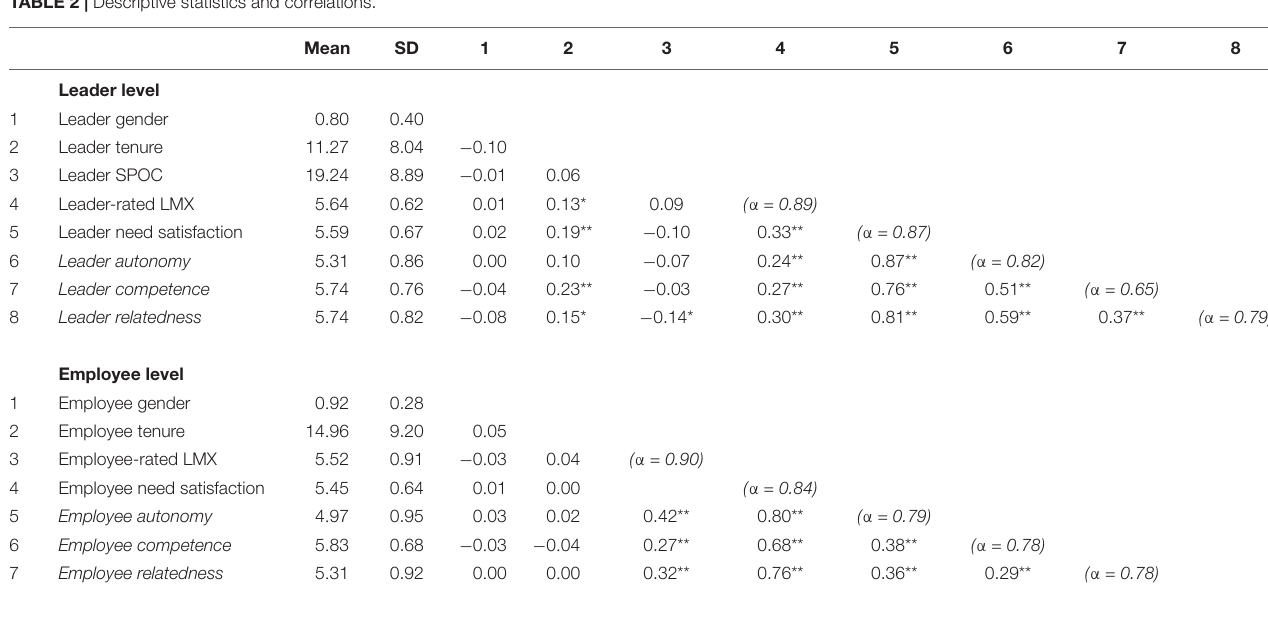
TABLE 2 | Descriptive statistics and